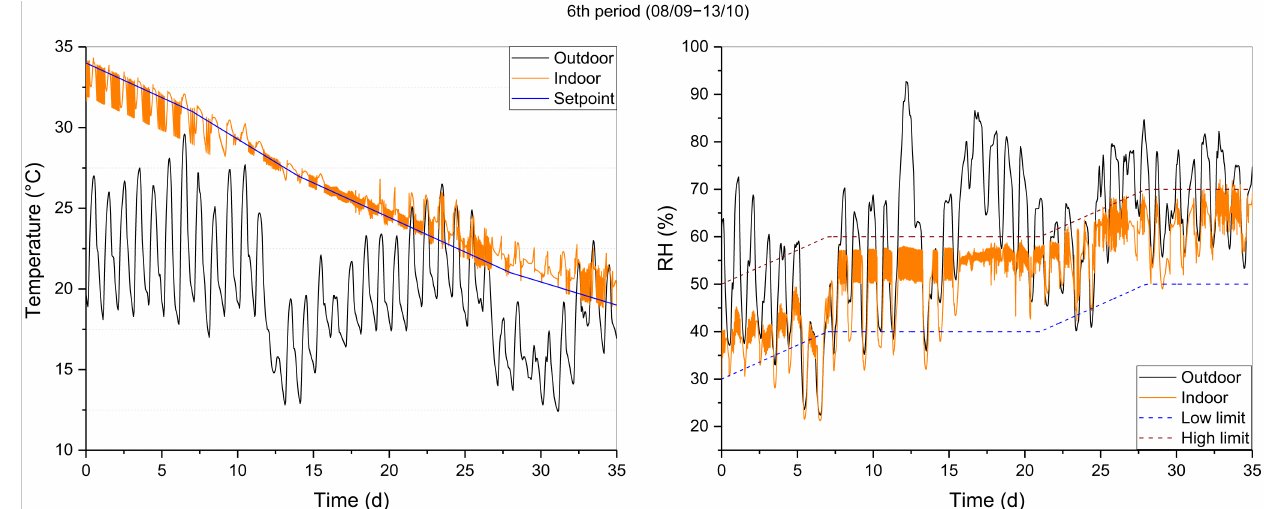
Figure 10. Temperatures and relative humidity variation during the 6th production period (08.09–13.10).